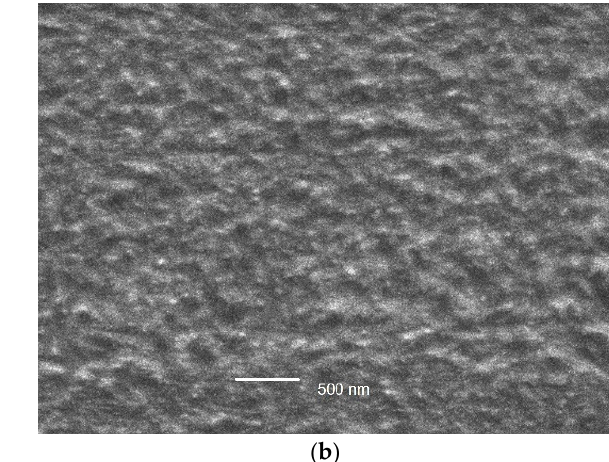
Figure 4. Molding process. ( a ) Injection mold with structured inserts and frame heating, ( b ) demonstrator component with two structured plates (40 × 40 mm) and bar casting and ( c ) influence